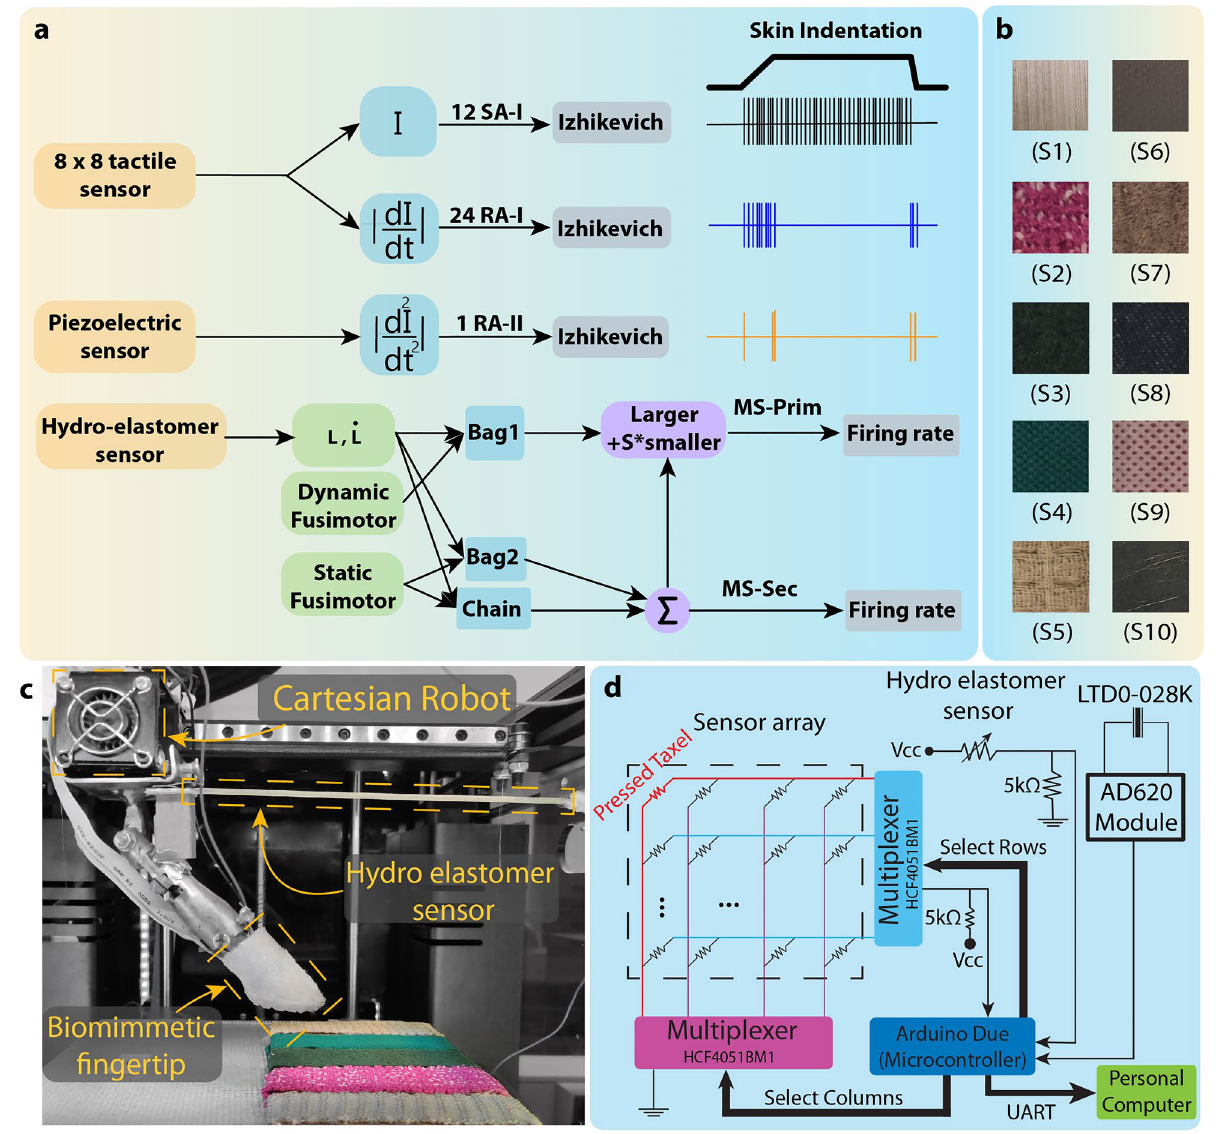
Figure 6. The illustration of the experimental setup comprises a robotic system with three degrees of freedom, three tactile sensors, and naturalistic textures. ( a ) Schematic of all preprocessing stages and converting recorded data to the appropriate input current to be applied to the Izhikevich neural model to produce spike trains. ( b ) Ten different naturalistic fine textures. ( c ) The experimental setup with the custom-built robot and sensors. A hydro-elastomer sensor to mimic muscle spindle (a proprioception sensor) for encoding the speed and position of the biomimetic finger. An 8 × 8 pressure tactile and piezoelectric sensors were embedded within a soft biomimetic fingertip to encode texture details during manipulation. ( d ) Scheme of the interface circuit for data The piezoelectric data were normalized and band-pass-filtered between 5 and 250 Hz using an eighth-order But- terworth filter to remove unwanted robot motor noise and the DC voltage before injecting it as the input of the Izhikevich neuron model (described below). Also, the recorded data of the hydro-elastomer sensor was filtered through a high-pass filter with a 1 Hz cutoff frequency and first order Butterworth filter to remove the noise. The hydro-elastomer data was mapped between 0.95 and 1.08 to be suitable as the input of the muscle spindle model. Neuromorphic encoding. Encoding spatial and temporal information is essential when processing dynamic stimuli such as textures. The Izhikevich neuron model was used to mimic the SA-I, RA-I, and RA-II tactile afferents’ activities. According to the previous research, the SA-I and RA-I afferents ratio is 1:2 36,45,46 and can be scaled up for the desired purpose. The Izhikevich model is described as follows;